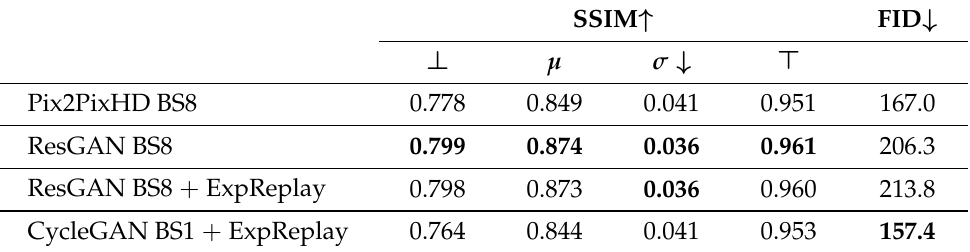
Table 2. Generation test results (170 images). Presents the minimum ( deviation ( σ ) and maximum ( ) values of SSIM and the FID results for each network, with respective (cid:62) batch sizes (BS).